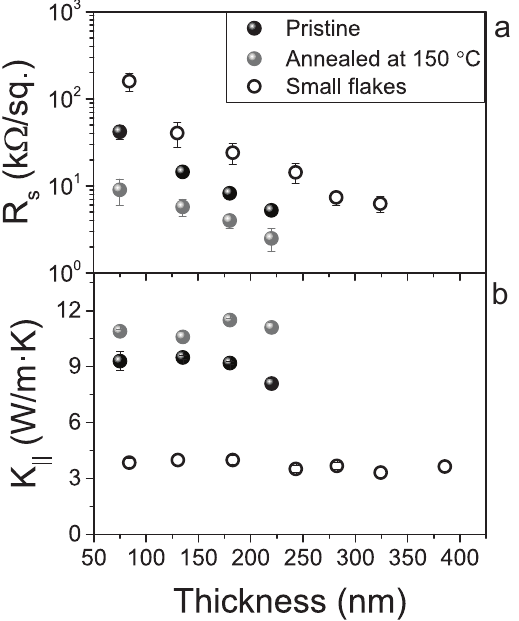
Figure 3. Thickness dependence of sheet resistance and in-plane thermal conductivity of inkjet- printed graphene films. The sheet resistance ( a ) shows a marked change with film thickness, size of the flakes and annealing. The in-plane thermal conductivity ( b ) shows negligible dependence on film thickness and annealing, whereas flake size has a more marked contribution. The thermal conductivity is expected to stay constant with film thickness if the microstructure is unaltered. Annealing increases the electrical conductivity more than the thermal conductivity. Flake size alters the boundary scattering length scale, as indicated in Figure 4.